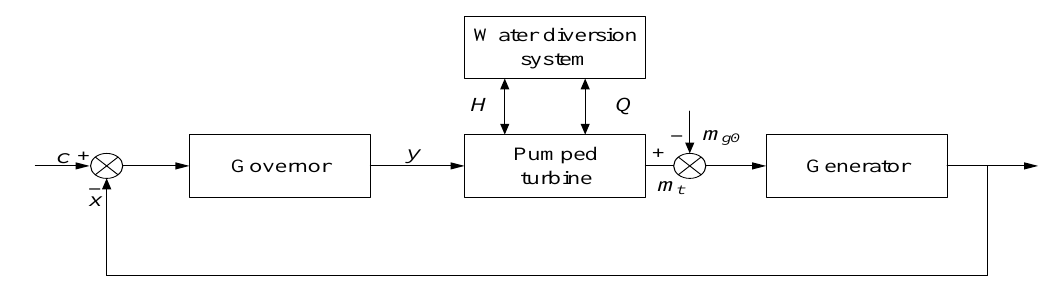
Figure 1. The structure of a pumped storage unit regulating system.